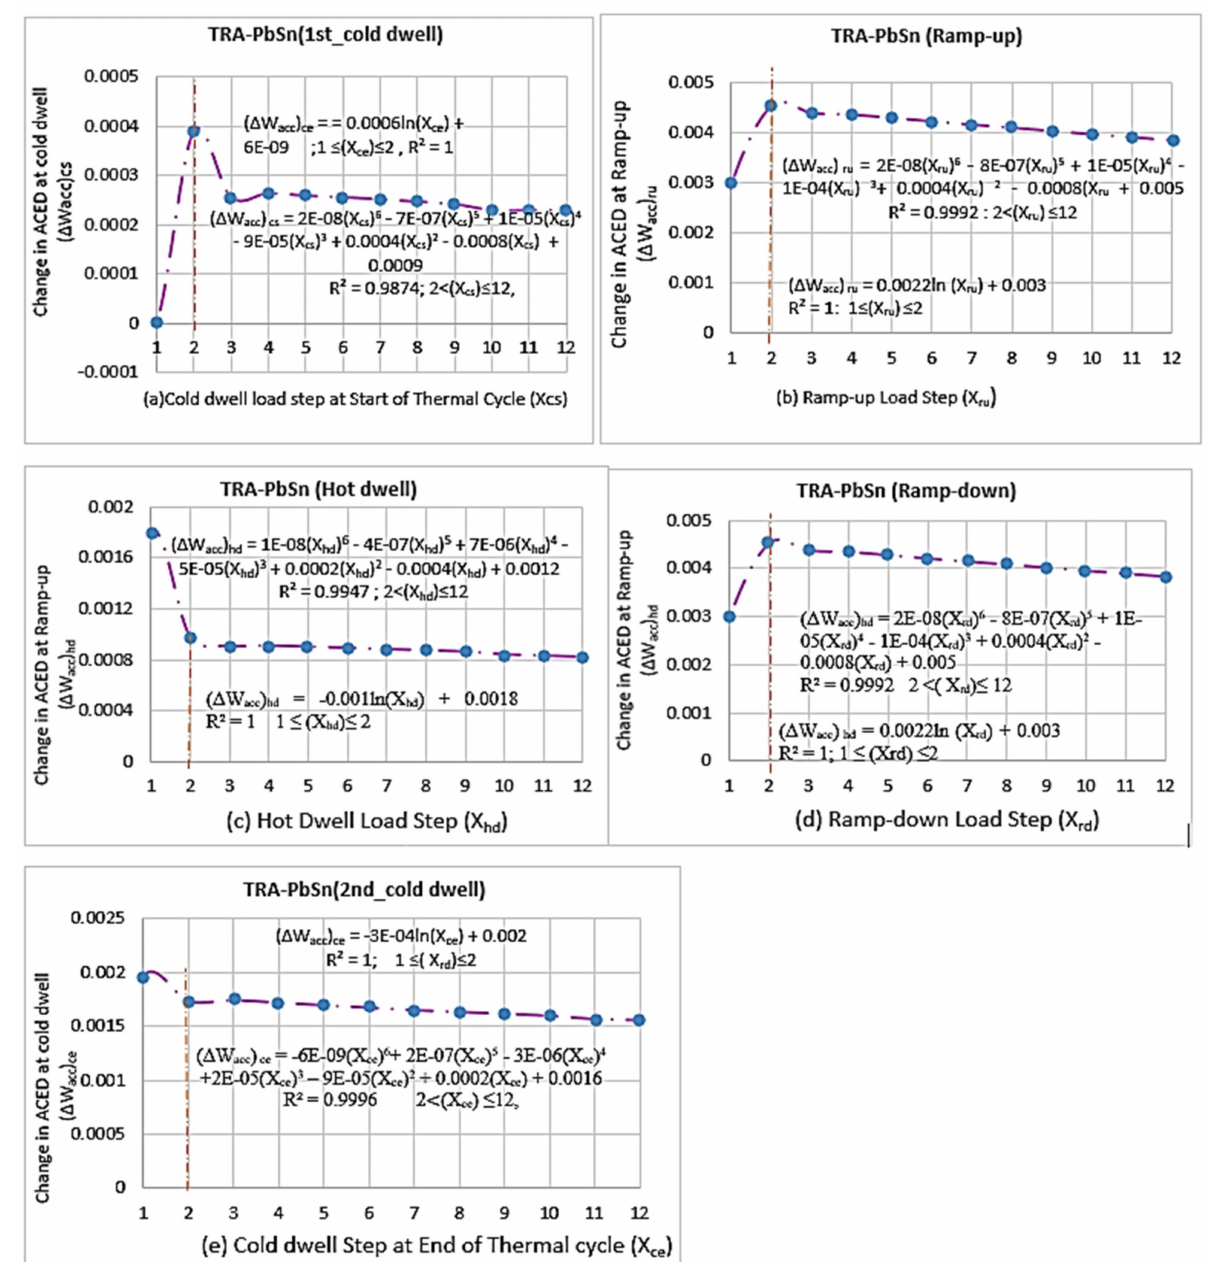
Figure 15. Change in ACED in PbSn Solder ( a ) 1st cold dwell, ( b ) ramp-up, ( c ) hot dwell, ( d ) ramp-down, ( e ) 2nd cold